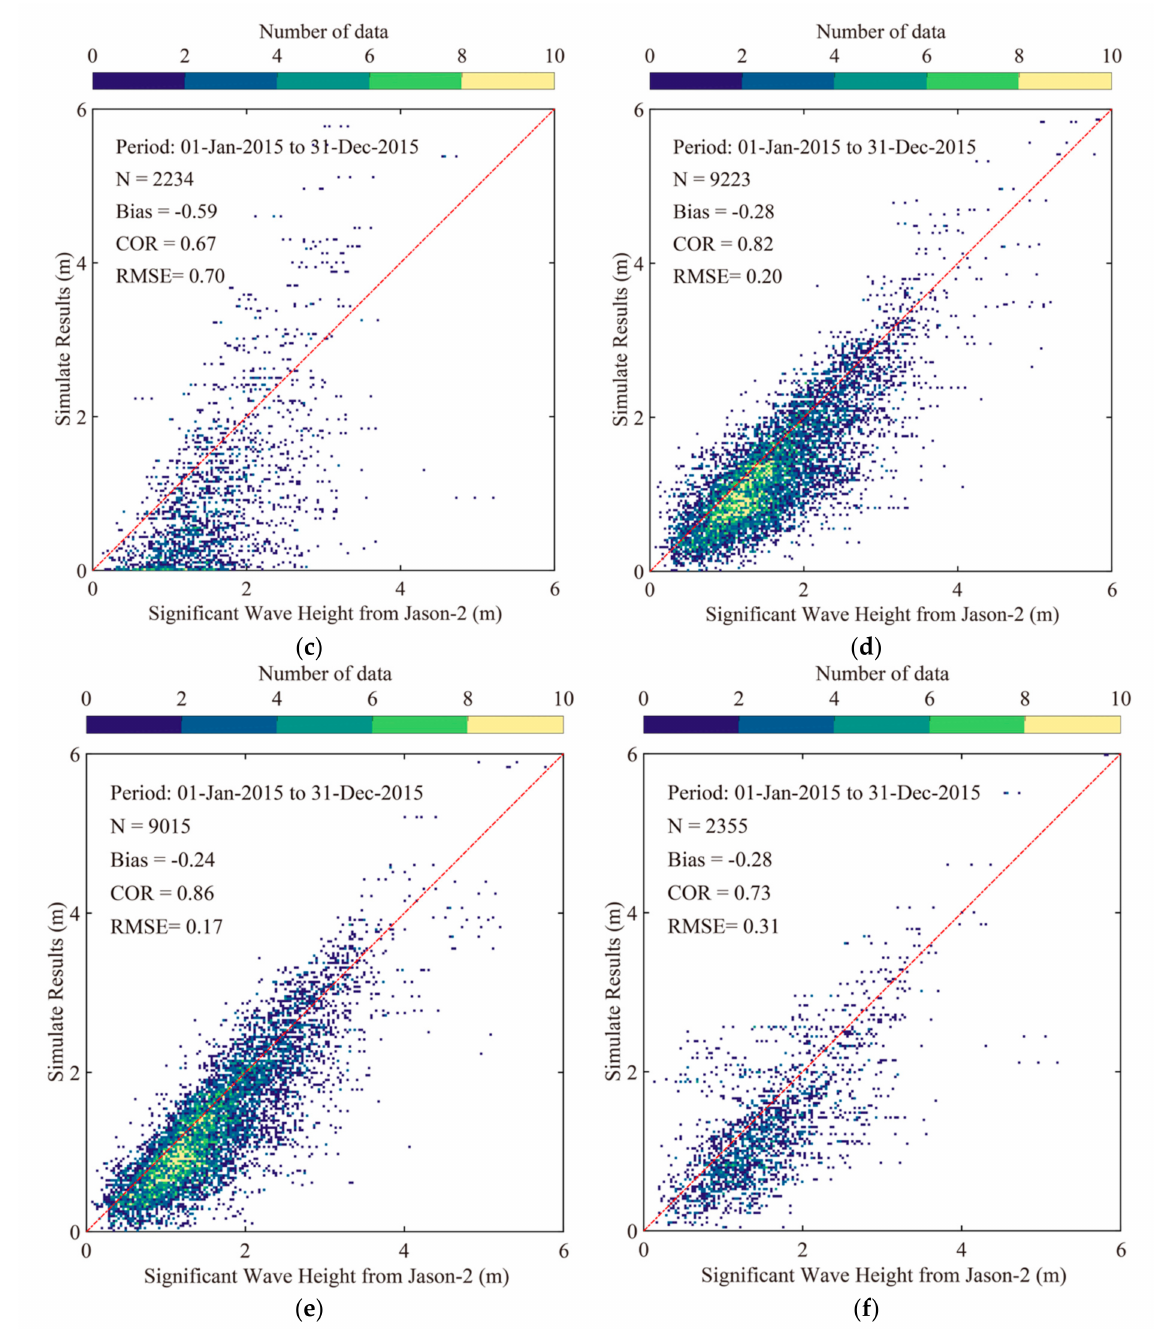
Figure 8. A comparison of SWH with wave measurements from the Jason-2 altimeter during the period from January to December 2015. ( a ) A comparison of SWAN-simulated SWH using ECMWF wind data. ( b ) A comparison of SWAN- simulated SWH using CCMP wind data. ( c ) A comparison of SWAN-simulated SWH using NCEP wind data. ( d ) A comparison of WW3-simulated SWH using ECMWF wind data. ( e ) A comparison of WW3-simulated SWH using CCMP wind data. ( f ) A comparison of WW3-simulated SWH using NCEP GFS wind